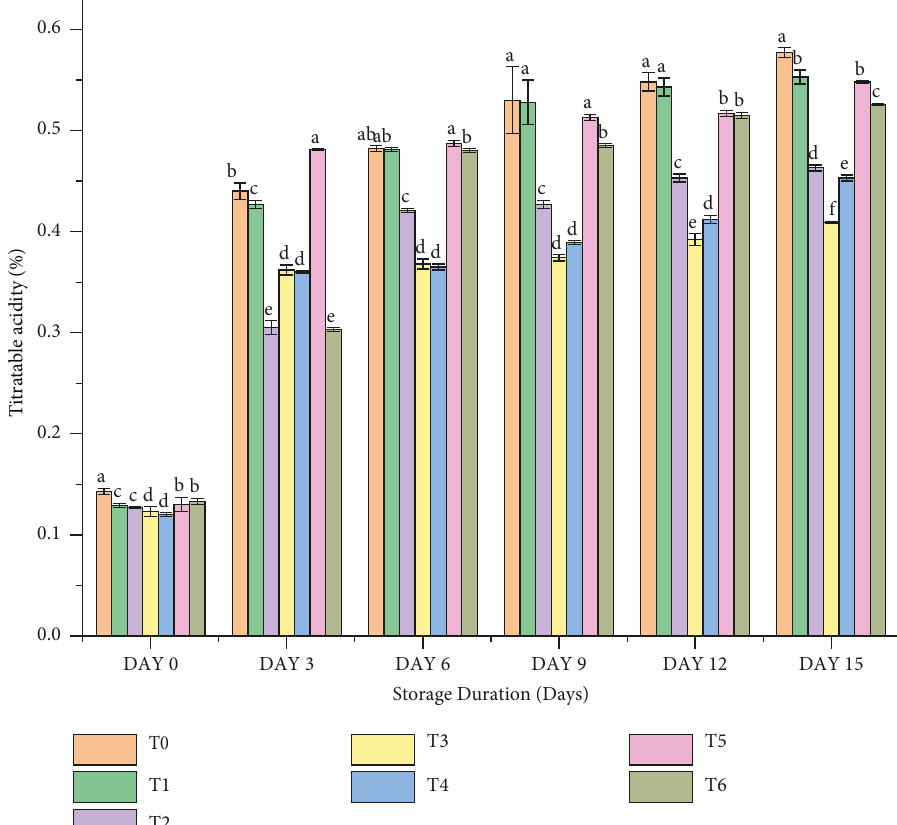
Figure 3: Effect of chitosan coating and cinnamon essential oil on titratable acidity (%) of pomegranate arils during storage at 4 ± 1 ° C. Vertical bars represent the mean ± SD of 3 replicates. Error bars with different letters on the same storage period show a significant difference ( P ≤ 0 . 05). T0 � control; T1 � 1% chitosan+0.25% oil; T2 � 1% chitosan+0.5% oil; T3 � 2% chitosan+0.25% oil; T4 � 2% chitosan+0.5% oil; T5 � 3% chitosan+ 0.25% oil; T6 � 3% chitosan+0.5%